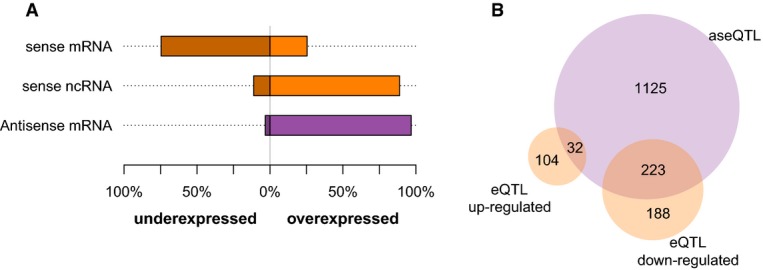
Influence of swc5 locus on sense and antisense expressionDirectionality of the effect of swc5-fs on expression for eQTL (orange) and
aseQTL (purple). Coding (mRNAs) and non-coding (ncRNAs) transcripts are distinguished. Fractions of
up- and down-regulated traits (relative to strains carrying the
swc5+ allele) are shown.Overlap between up- and down-regulated eQTL targets and aseQTL targets of the
swc5 locus. The overlap between down-regulated eQTL and aseQTL targets is highly
significant (P = 2.2e-16, one-sided Fisher's exact test), whereas
there is a significant depletion of down-regulated eQTL targets among the aseQTL targets
(P = 0. 006302, one-sided Fisher's exact test).